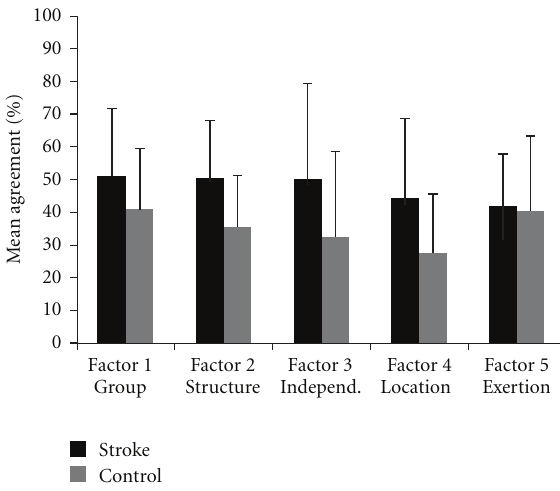
Figure 1: Mean scores for stroke and control groups on each of the 5 a priori EPQ factors (standard deviations are